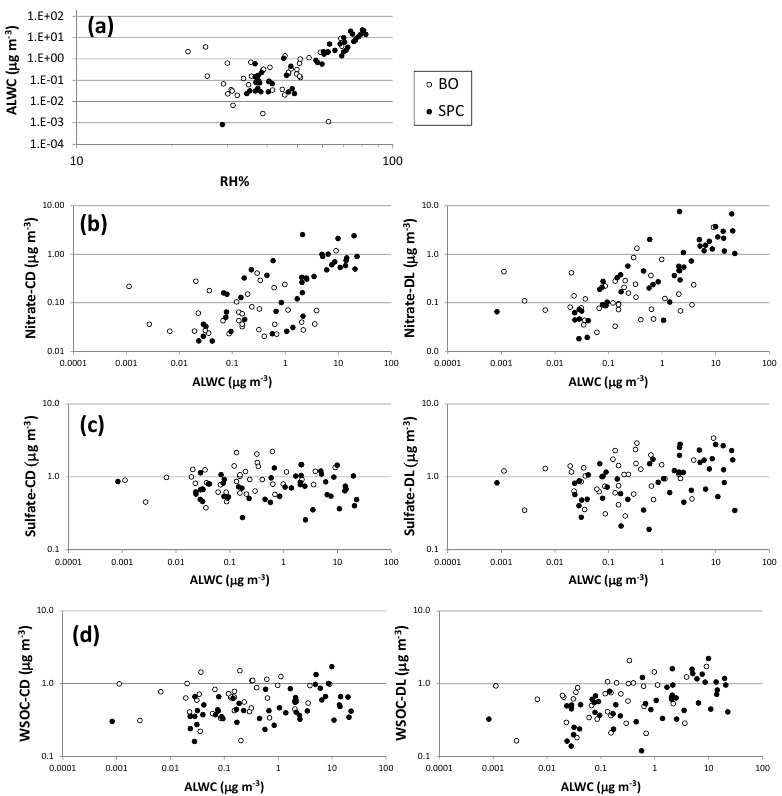
Figure 8. Relationship between ALWC and RH% (a) ; relationship between nitrate (b) , sulfate (c) and WSOC (d) in the condensation (CD, left panel) and in the droplet (DL, right panel) mode of particles and ALWC averaged over the sampling periods of the Berner